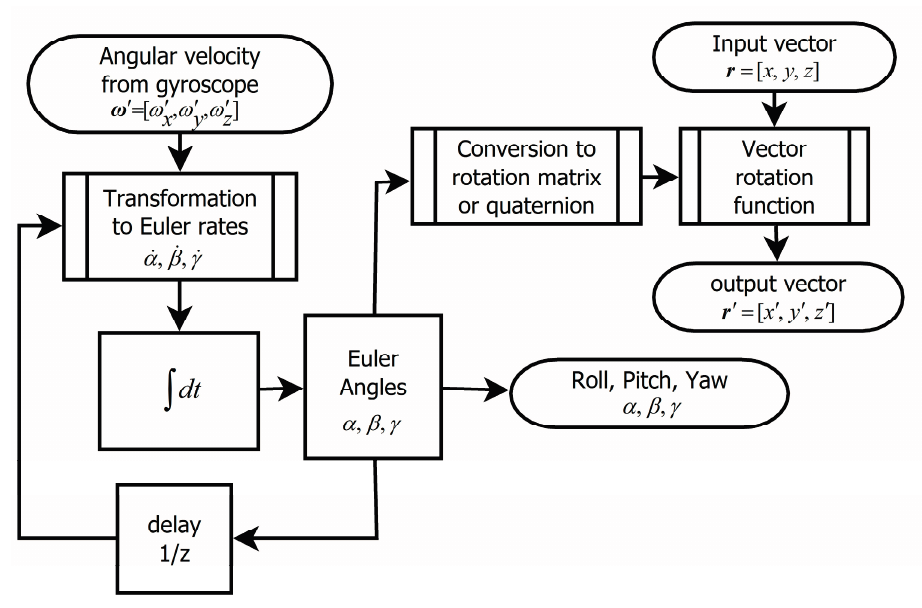
Figure 8. The algorithm based on Euler angle rates integration.